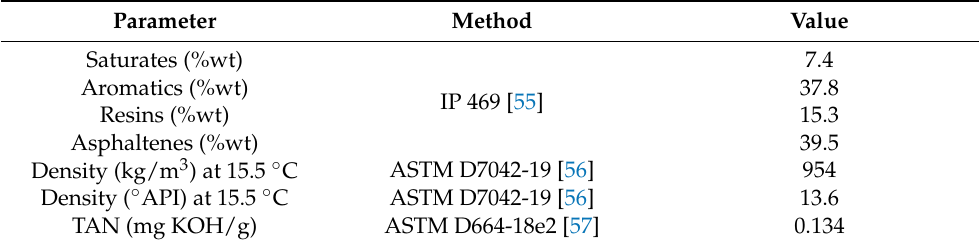
Table 1. Properties of the Colombian heavy crude oil used in this work. Parameter Method Value Saturates (%wt) 7.4 Aromatics (%wt) 37.8 IP 469 [55] Resins (%wt) 15.3 Asphaltenes (%wt) 39.5 Density (kg/m 3 ) at 15.5 ◦ C ASTM D7042-19 [56] 954 Density ( ◦ API) at 15.5 ◦ C ASTM D7042-19 [56] 13.6 TAN (mg KOH/g) ASTM D664-18e2